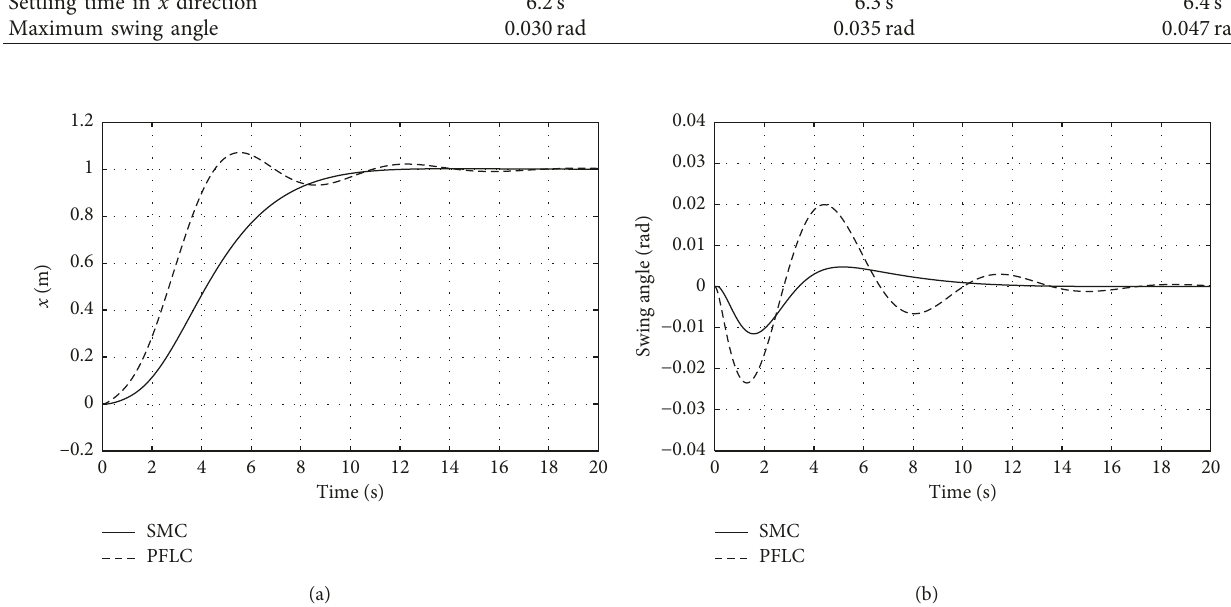
Figure 9: Quadrotor’s position along the X -axis and pendulum swing angle, comparison of the proposed SMC with the PFLC controller for l � 2m and m � 0.5 kg.